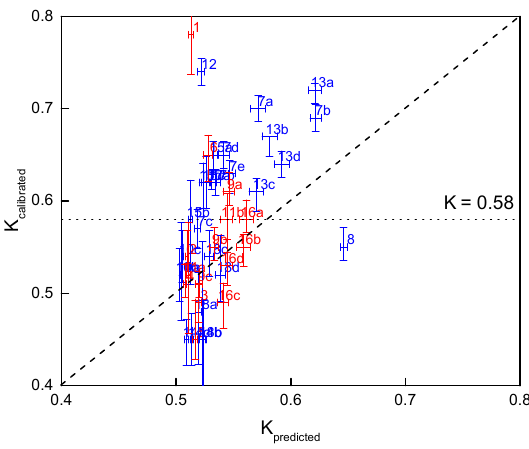
Figure 5. Comparison between predicted and calibrated K values. Labels are used to distinguish estuaries. The blue marks used K m from Cai et al. (2012) and the red ones from Gisen (2015a); 25% sensitivity of fresh water discharge is indicated by the